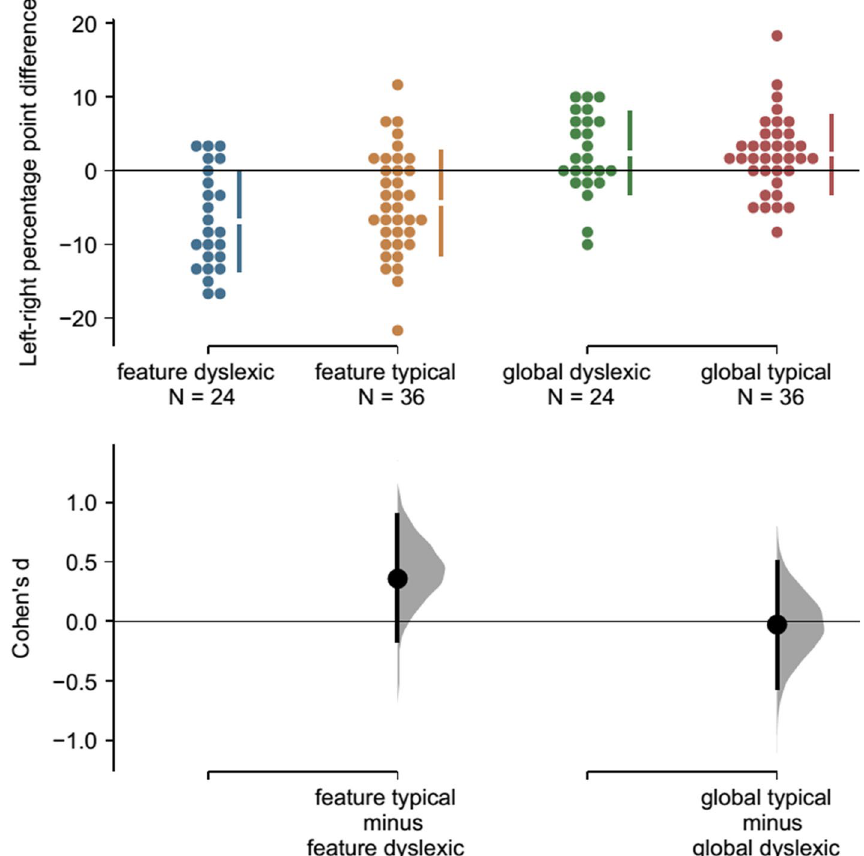
Figure 4. Cumming plot depicting laterality effects of dyslexic (blue and green dots) and typical readers (yellow and red dots). Upper panel: Each dot corresponds to one person’s laterality effect (accuracy for left-facing stimuli minus accuracy for right-facing stimuli); means and standard deviations are plotted as gapped lines. Lower panel: Effect sizes (Cohen’s d) are depicted as dots. Filled curves depict the resampled distribution of the group differences, given the observed data, and error bars represent 95% confidence intervals (bootstrapped). Image is based on code developed by Ho, Tumkaya, Aryal, Choi, and Claridge-Chang 87